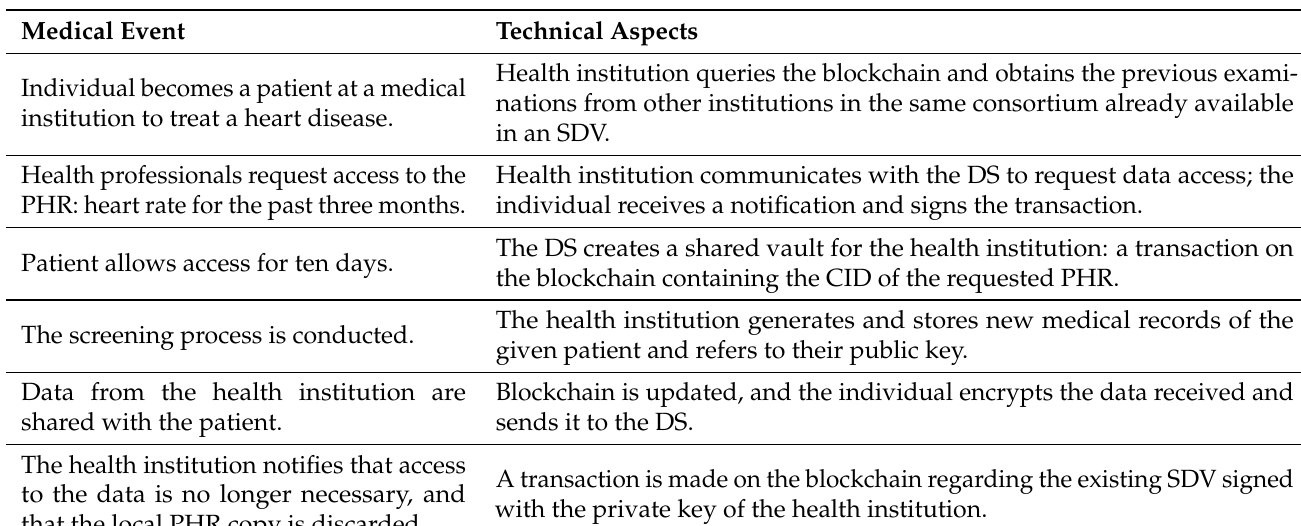
Table 4. Example scenario with actions taken by the participants in the proposed